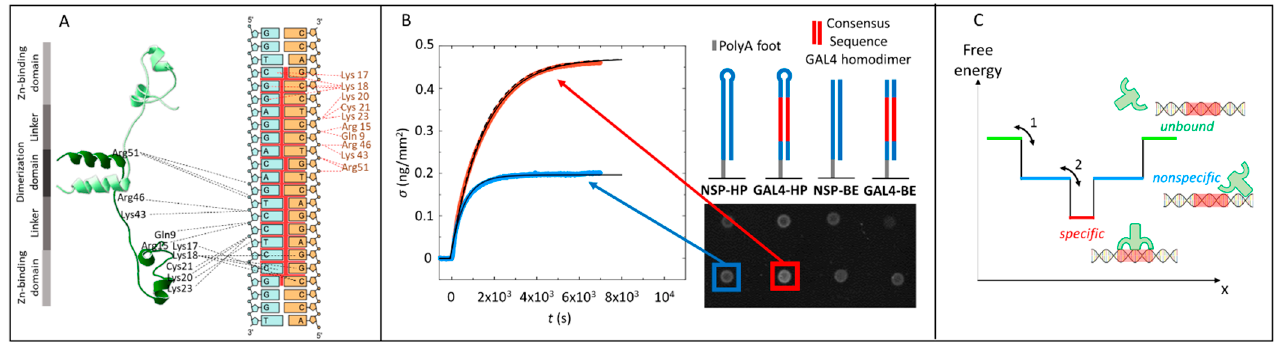
Figure 1. Gal4–DNA interaction measured by the Reflective Phantom Interface (RPI). ( A ) Sketch of the Gal4 (8–64)/DNA complex based on The Protein Data Bank (PDB) 3COQ, with the two subunits of the dimer colored in light and dark green, respectively. Dashed lines indicate hydrogen bonds (HB) between Gal4 amino acids and the consensus sequence. ( B ) Binding curves of Gal4 on specific and nonspecific DNA sequences measured by the RPI. Time evolution of the surface density of protein binding on two different spots with specific (red) and nonspecific (blue) DNA sequences upon the addition of 10-nM Gal4 in the solution. Sketches of the immobilized sequences and RPI images of the DNA spots are reproduced aside. Black lines are fit to the experimental curves with Equation (4). The dashed line corresponds to the highest calculated rate of binding, as discussed in Supplementary Text S6. ( C ) Sketch of the energy profile of the protein–DNA complex vs. a generic reaction coordinate x. The width along x of the nonspecific and specific wells mimic the number of conformations accessible to the